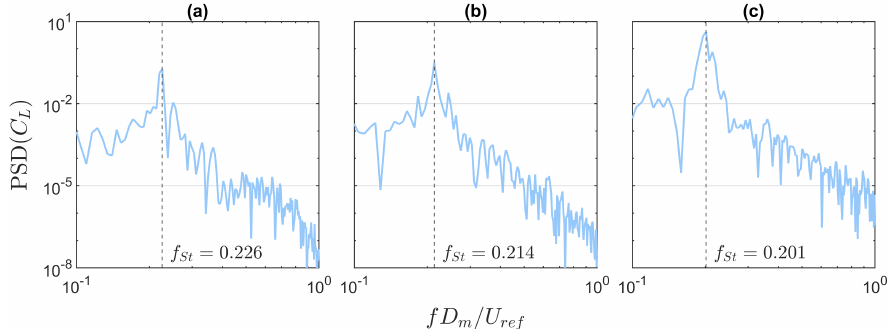
Figure 8. Power spectral density of lift fluctuations for the baseline ( a ) and wavy cases A03 ( b ) and A11 ( c